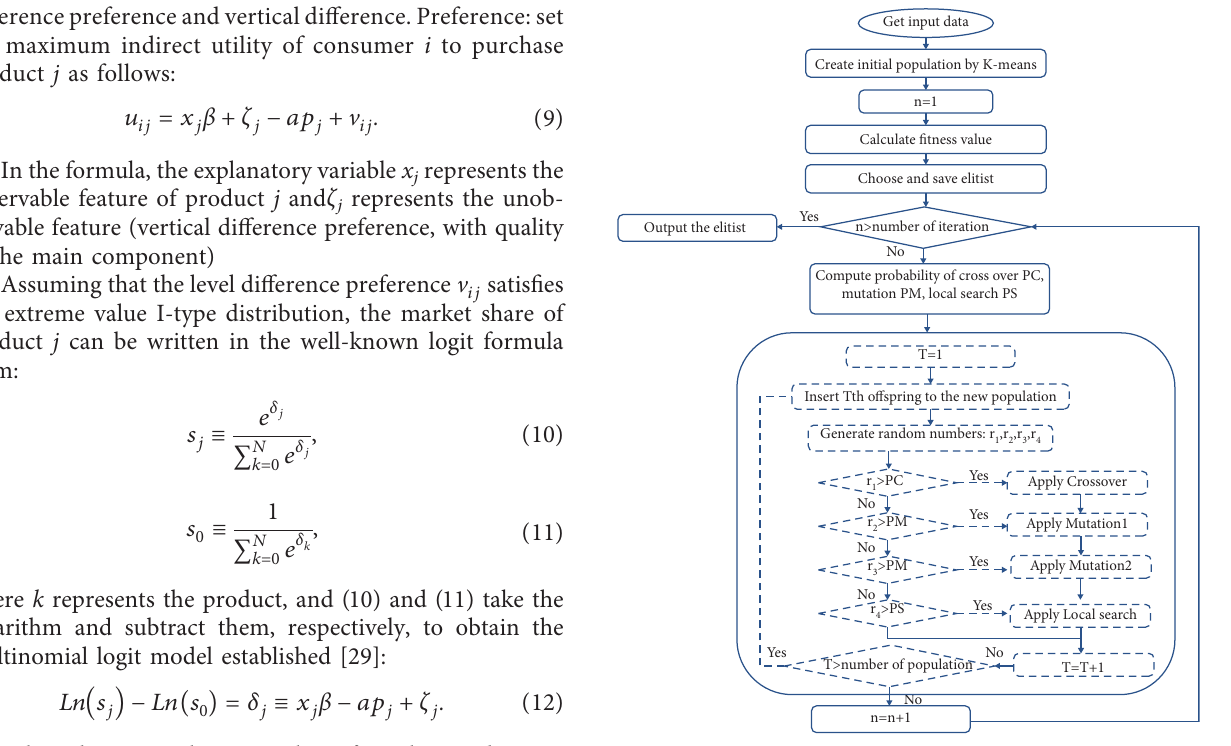
Figure 7 is the influence diagram of error parameters.